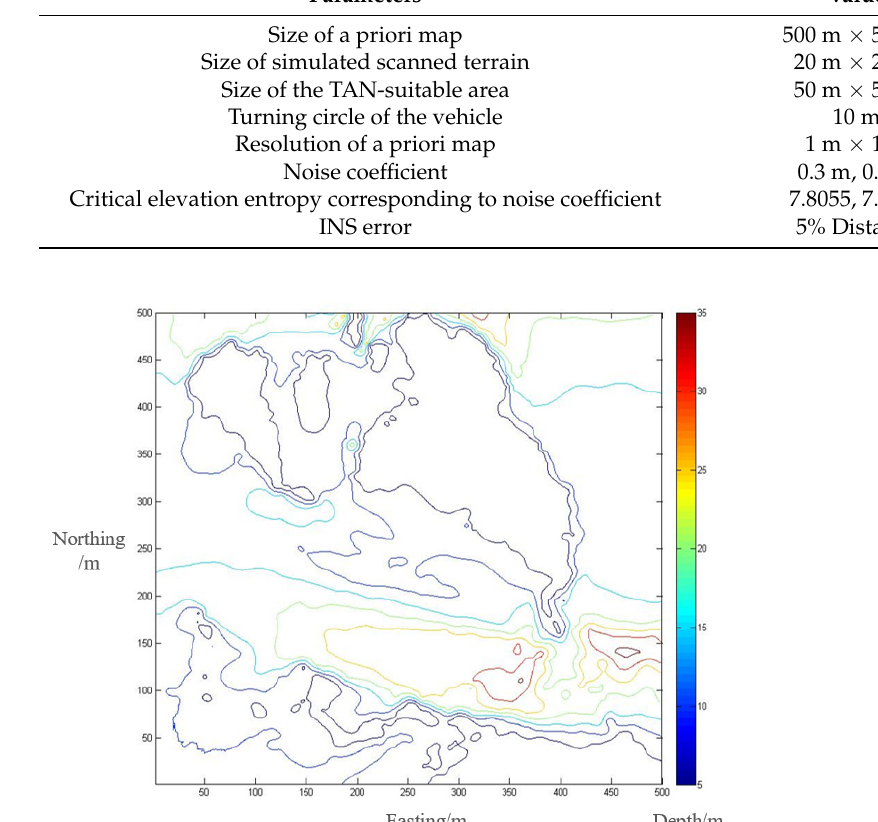
Figure 13. A priori map in the simulation.